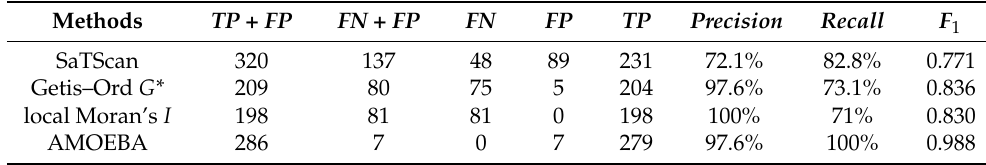
Table 1. Cell-based evaluation results of hotspots on synthetic